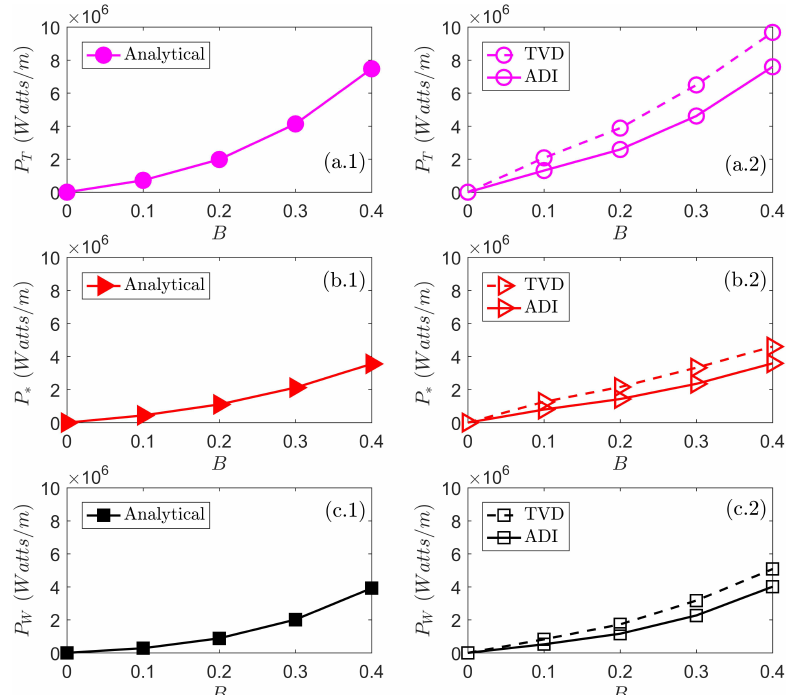
Figure 10. Effect of the blockage ratio on P T ( a.* ), P ∗ ( b.* ), and P W ( c.* ). Solutions from the analytical model (filled markers), TVD (dashed line), and ADI (continuous line). Reproduced from [55] with permission from